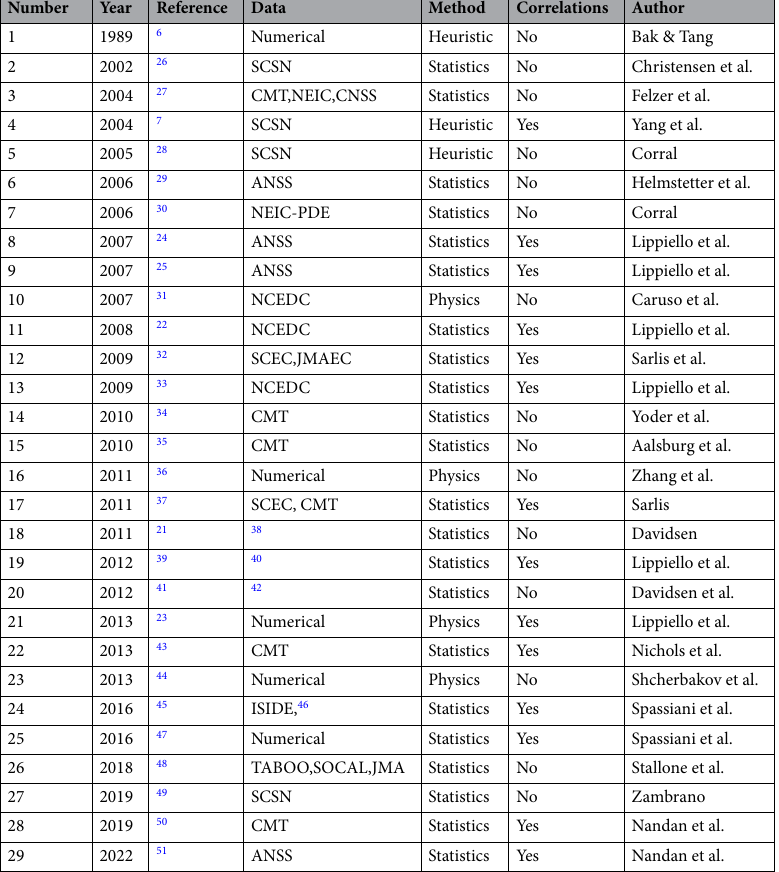
Table 1. Scientific papers considered in the meta-analysis.